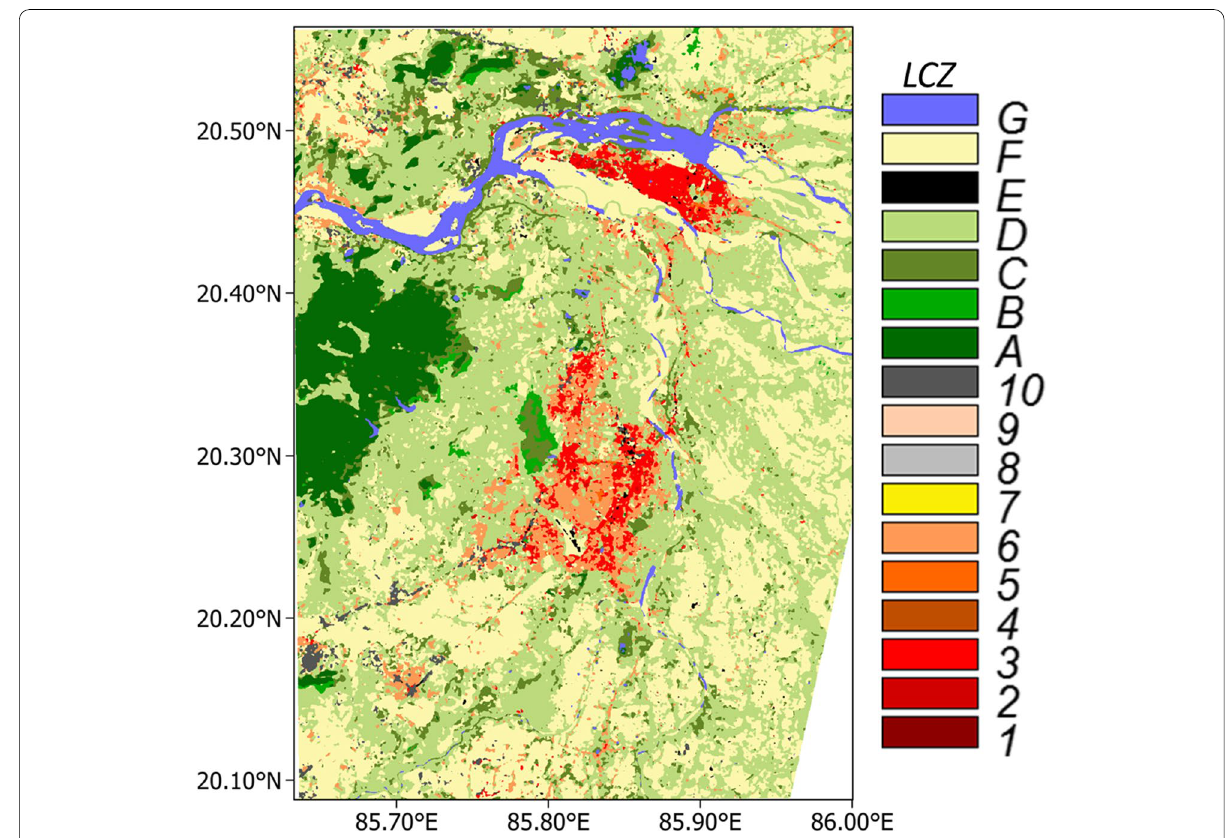
Fig. 1 Local Climate Zone map of Bhubaneshwar,